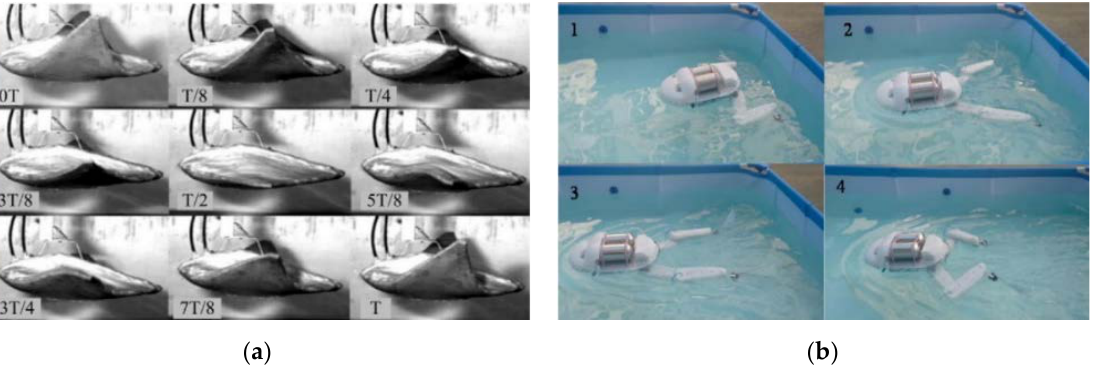
Figure 5. McKibben-type aquatic robots: ( a ) the undulation/oscillation bionic aquatic robot Robo- ray II [85] , reproduced with permission from [85] , 2010, Springer Nature; ( b ) frog-inspired rowing robot [88] .